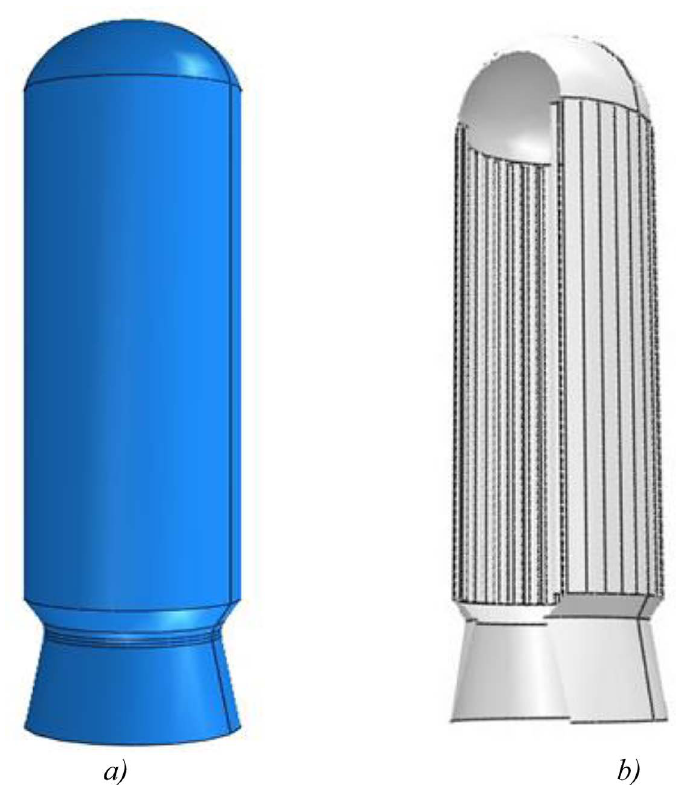
Figure 2. Schematic of combustion chamber: (a) unbaf fl ed and (b) baf fl ed.